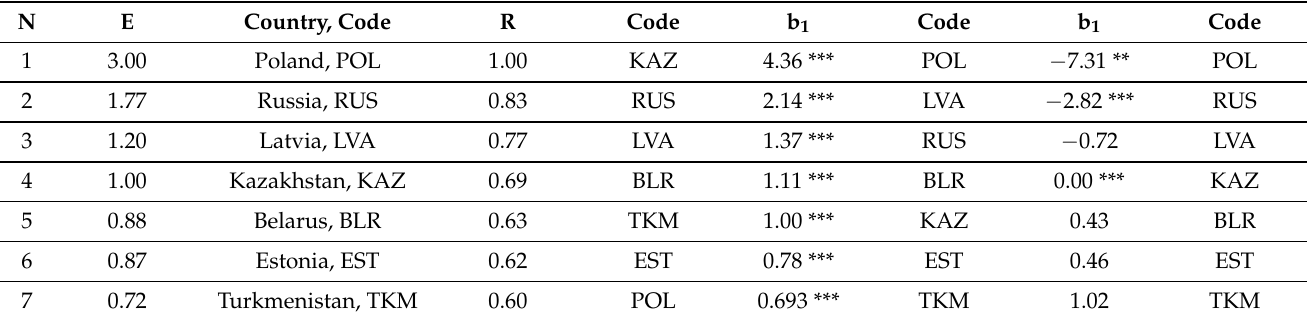
Table 2. Distribution of countries by MNC, estimates of regression parameters, correlation coefficients, and elasticity coefficients. Note: Compiled by the authors from a source of statistical data [31], via